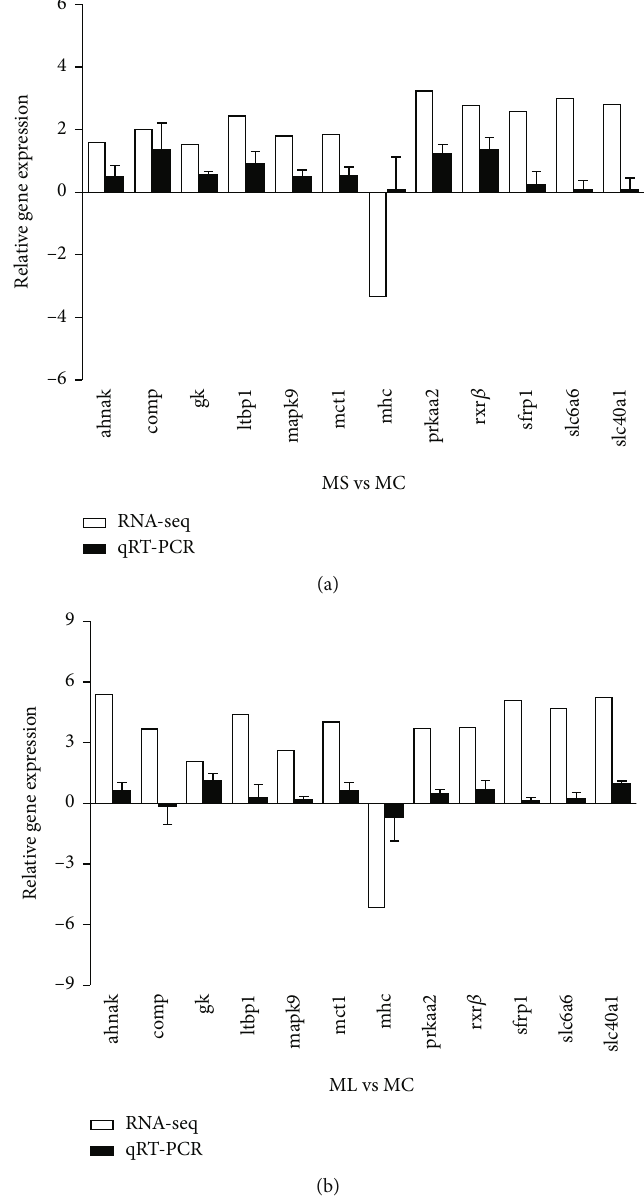
Figure 9: Validation of the expression of DEGs by qRT-PCR. Relative expression abundances of 12 DEGs validated by qRT-PCR in MS vs . MC (a) and ML vs . MC (b). The transcript level was measured by quantitative real-time PCR (qRT-PCR) and normalized to the abundance of a housekeeping gene ( β - actin). The data are represented as means ± SD ( n = 3 ). MC: muscle in the control group (continuously fed for 14 days); MS: muscle in the starved group (starved for 3 days); ML: muscle in the starved group (starved for 14